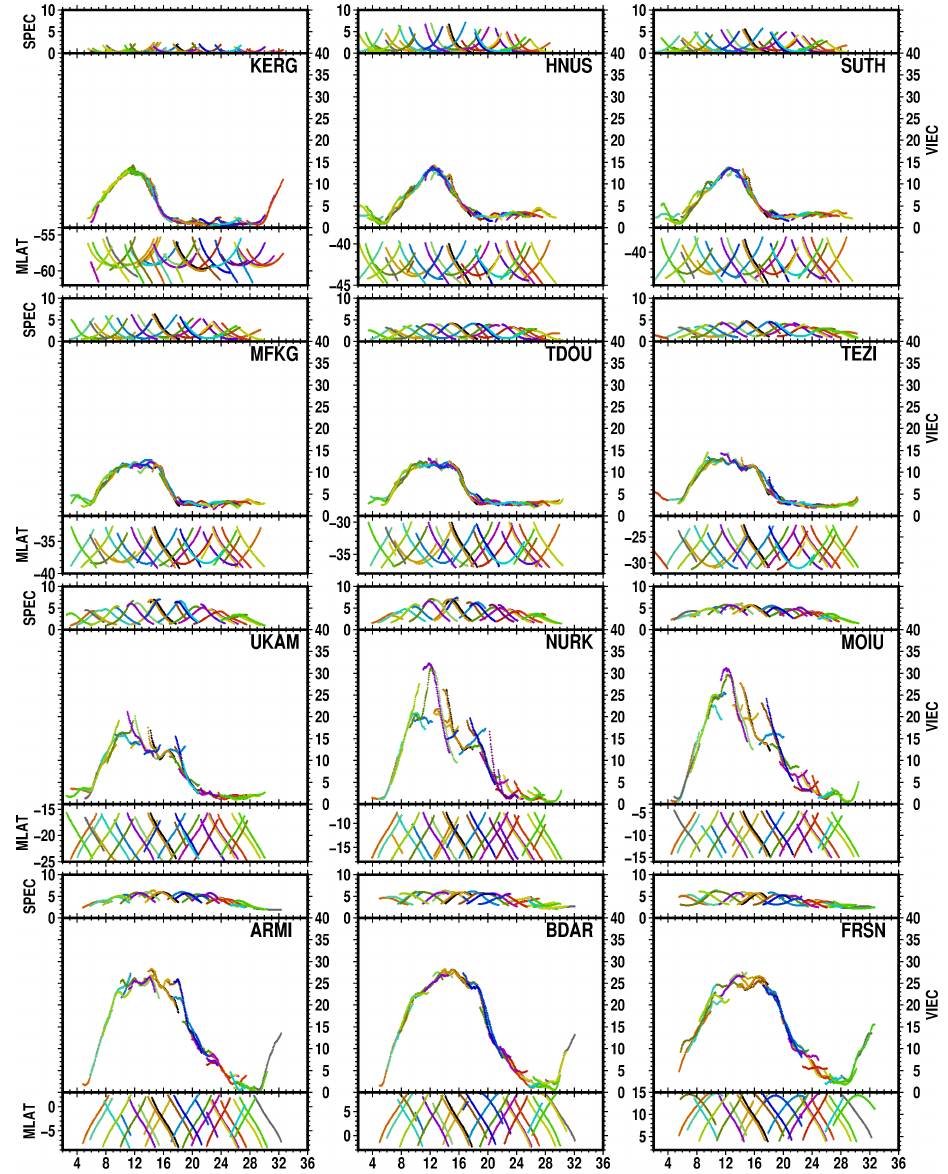
Figure 3. The diurnal TEC variations for the GPS stations, displaying, for each station, the magnetic latitude of the IPP in the bottom panel, the equivalent vertical ionospheric electron content (VIEC) in the middle panel, and the slant plasmaspheric electron content (SPEC) in the top panel, versus the magnetic local time at the IPP. Data segments are color-coded by GPS